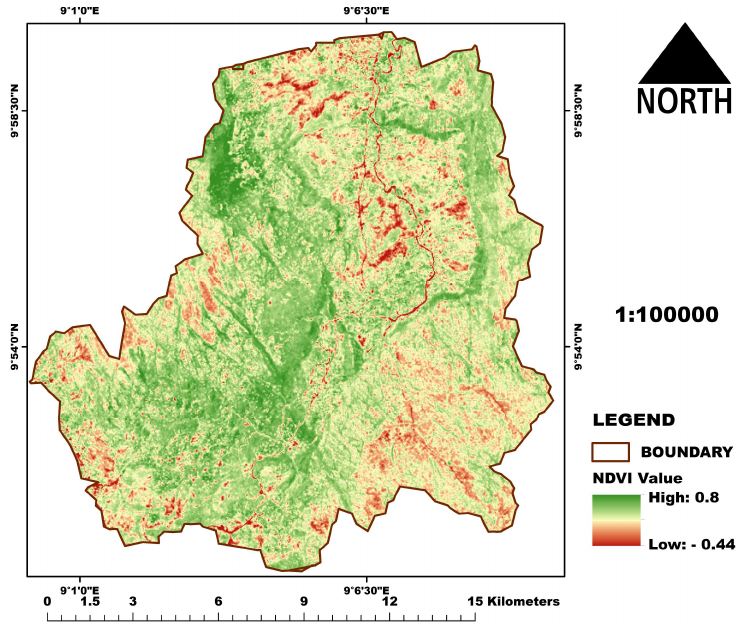
Figure 3. Normalized difference vegetation index (NDVI) of Koromi catchment.